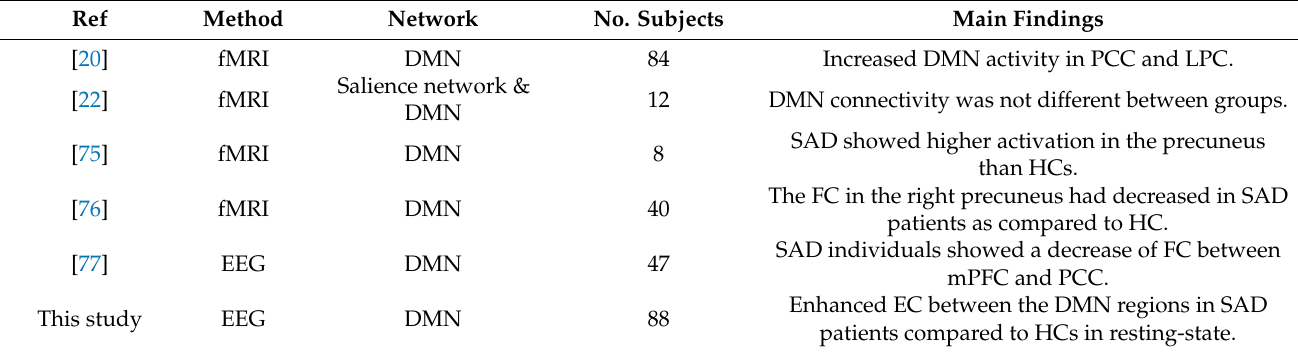
Table 4. A comparison between the current study and relevant studies in the literature. Ref Method Network No. Subjects Main